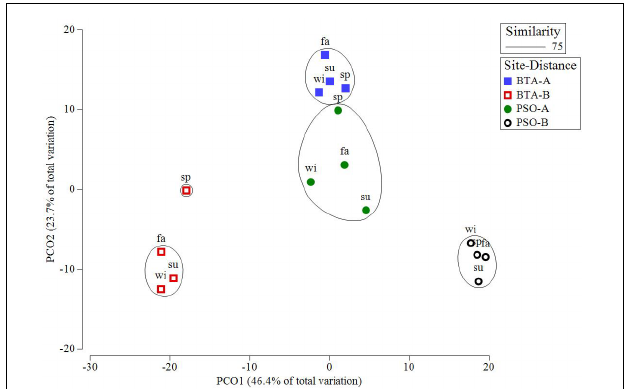
FIGURE 10 | Principal coordinates ordination (PCO) plot of benthic community structure on site by distance based on Bray-Curtis similarity matrix. Cluster represent 75% of similarity within groups. This model explained 75% of the observed spatio-temporal variation in benthic cover. Blue and red squares represent Bahía Tamarindo (BTA); green and black represent Punta Soldado (PSO). Seasons are defined as: sp, spring; su, summer; fa, fall; wi,